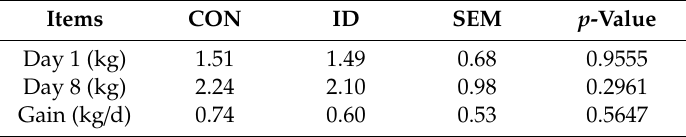
Table 1. Growth performance of neonatal piglets with or without iron supplementation.